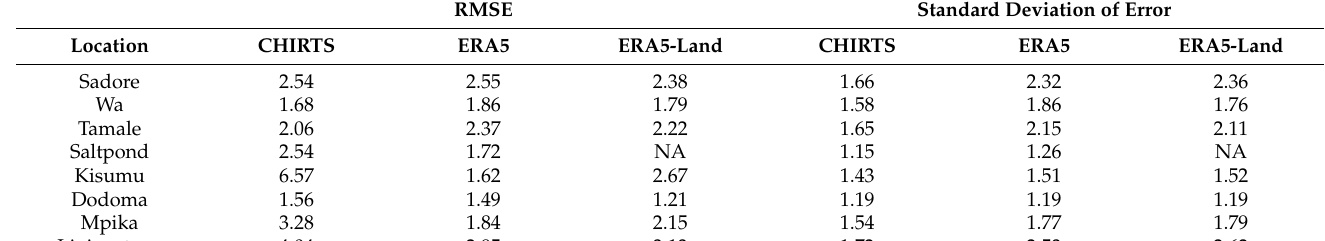
Table 4. RMSE and standard deviation of error between the minimum temperatures of the station data and the gridded products.